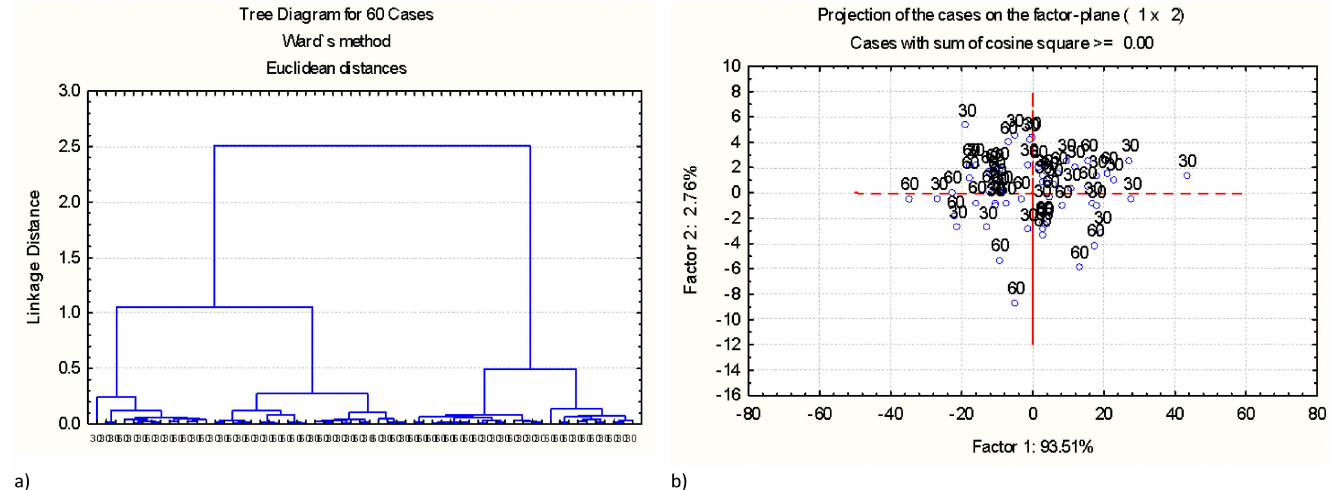
Fig 3. Multivariate molecular spectral analysesof protein fingerprint region at ca. 1718–1481 cm -1 . Comparisonof samplesprocessedunder different time using cluster analysis(Cluster method: Ward’s algorithm; Distancemethod: Euclidean)and principalcomponentanalysis[Scatter plots of the 1st principalcomponents(PC1) vs. the 2nd principalcomponents(PC2)]: (a) CLA: samples conditionedfor 30s (30) vs. samplesconditionedfor 60s (60); (b) PCA: samplesconditionedfor 30s (30) vs. samples conditioned for 60s